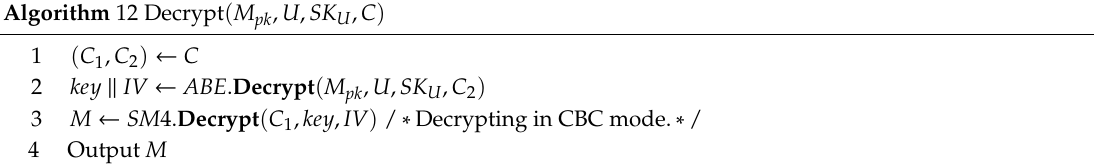
Algorithm 12 Decrypt ( M pk , U , SK U , C